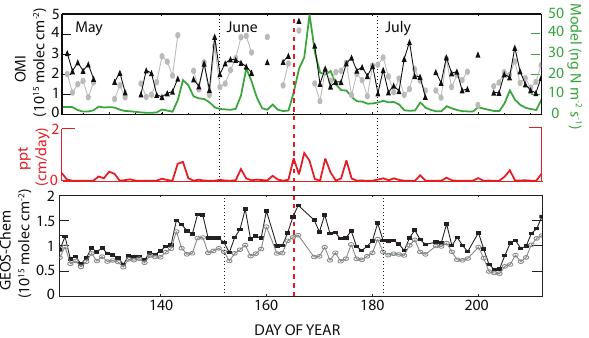
Fig. 5. May–July 2006 timeseries of soil NO pulsing events over rural South Dakota (43–45 ◦ N, 98.75–96.25 ◦ W). OMI NO 2 col- umn densities (top) for the Standard Product (black triangles) and DOMINO Product (grey circles) are compared with predicted soil NO emissions (top, green) and precipitation (middle, red). GEOS- Chem NO 2 column density with soil NO emissions included (bot- tom, black) and not included (bottom, gray).